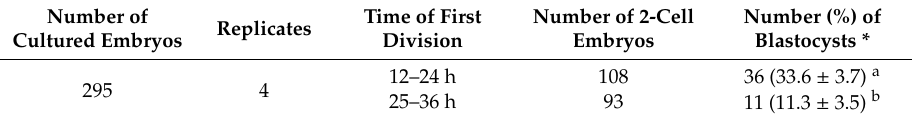
Table 1. In vitro development of SCNT embryos with di ff erent first division